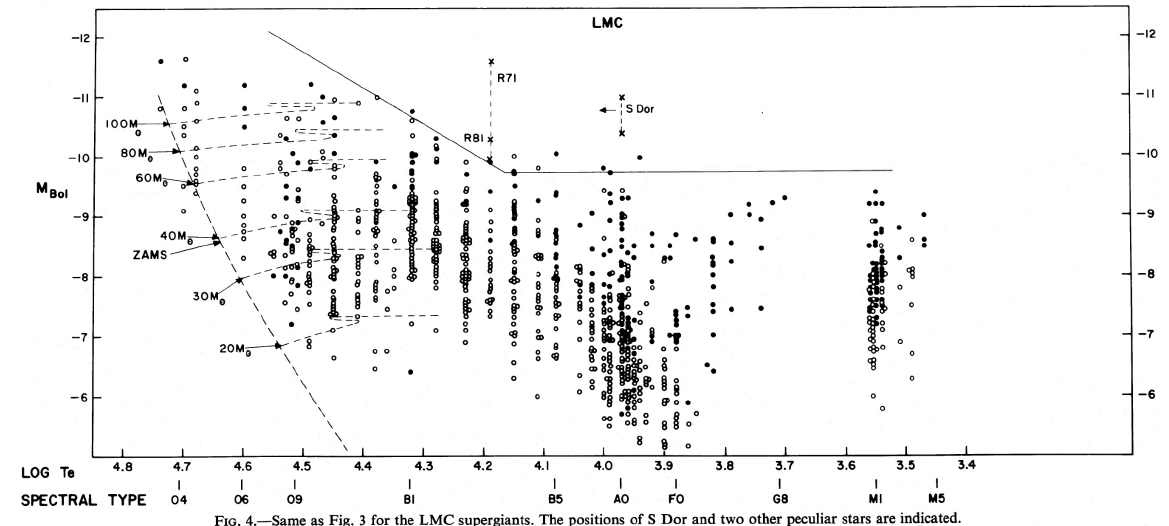
Figure 2. The HR Diagram, M Bol vs. log T, for the luminous stars in the Milky Way from [25].